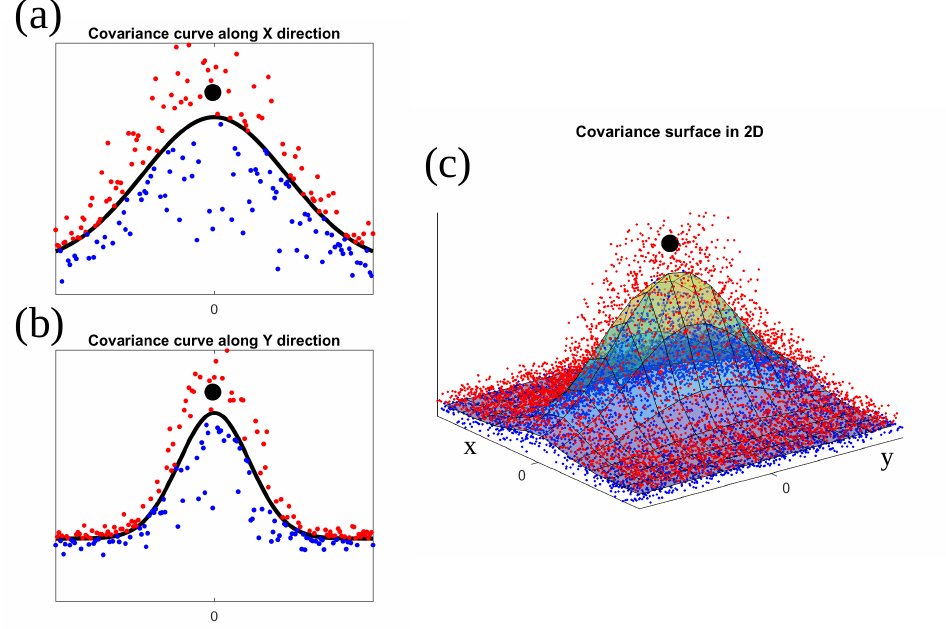
Figure 1. Sketch of the PROM method for a 2D case (i.e., anisotropic). The dots are products of pairs innovations (where one of the elements of the pair being close to the point where the covariance is computed) located at position ∆ r computed as the vector difference between the locations of the “far” innovation and the one in the central bin. The model covariance (an anisotropic 2D Gaussian surface in this case) is fitted to all innovation products. For clarity we have plotted in red colour the products above the fitted Gaussian surface and in blue those below, representing the fact that the fitted covariance function tends to be somewhere in the middle. The plots in panels ( a , b ) represent profiles of the covariance functions along the X and Y axis to show the anisotropy of the function and data while the plot in panel ( c ) shows the full covariance function fitted to all the data. The black dot represents the variance of the innovations at the centre r 0